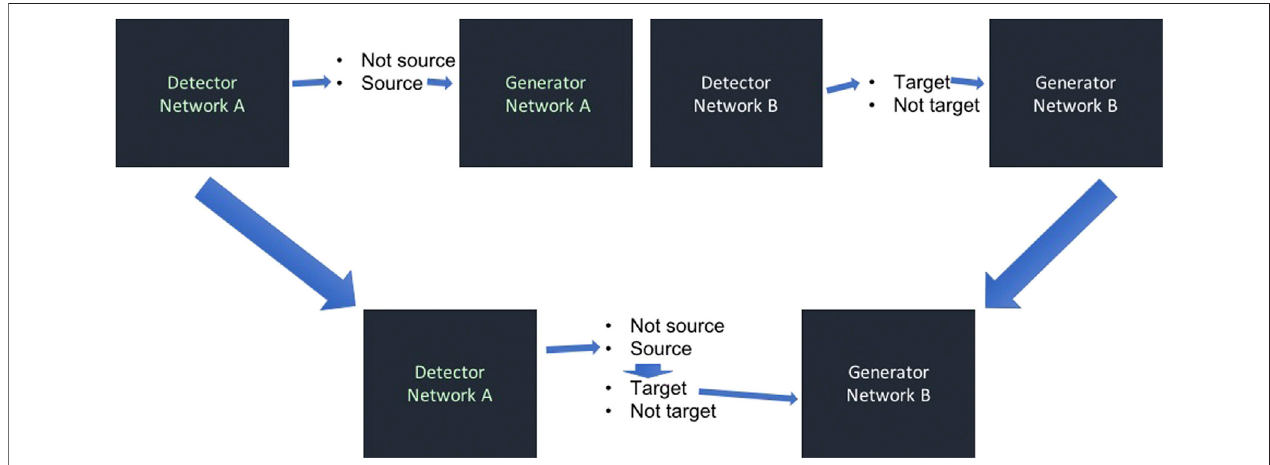
FIGURE 5 | Basic technology for the creation of deepfakes. Network A is trained to recognize the source person even from distorted or noisy images, and con fi gured such that it outputs a noiseless picture of the target person. Network B is trained on the target person in the same manner. After training, the output of the detector of the source person is fed as input to the generator of the target person. Thus, wherever the source person is detected in an input video, it is replaced by the target person.